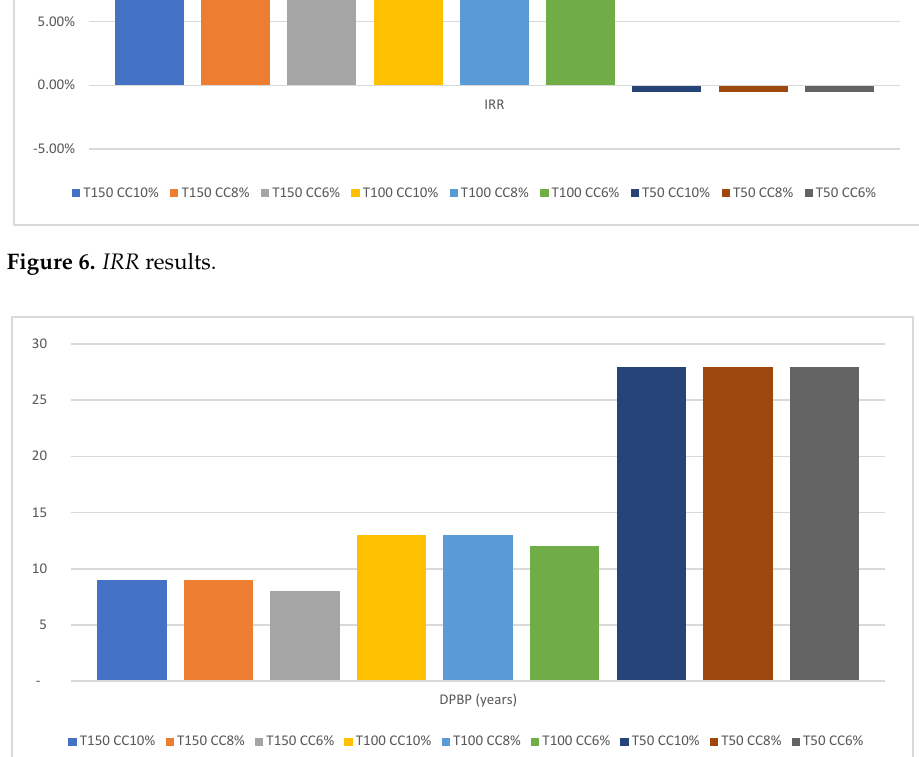
Figure 7. DPBP results.